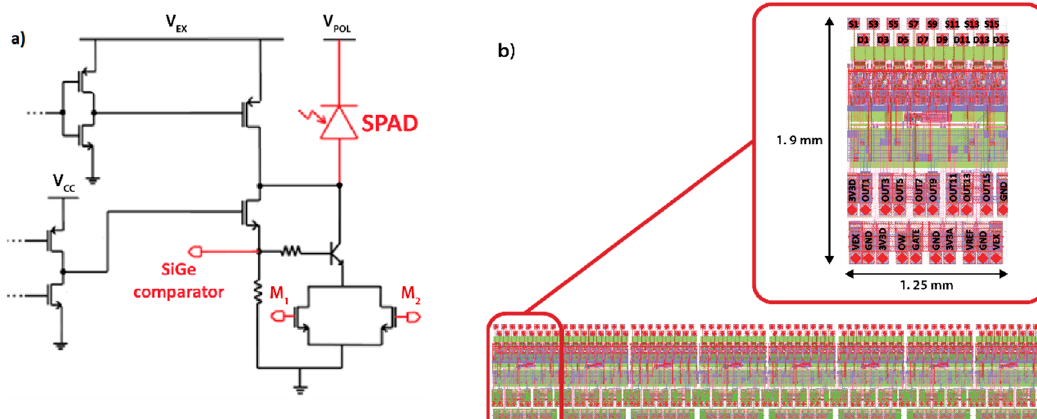
Figure 1. ( a ) Simplified schematic of the Single-Photon Avalanche Diode (SPAD) pulser circuit: the Bipolar Junction Transistor (BJT) transistor connected at SPAD anode node is active during the OFF-to-ON transient of the SPAD. The Metal-Oxide-Semiconductor (MOS) transistors M1 and M2, driven in ohmic regime, allow the variation of the current drawn by the BJT, thus the transient of the SPAD anode. An identic circuit (not shown) drives the dummy device and allows for differential sensing. ( b ) Layout of the complete 64 × 1 fast-gating Active Quenching Circuit (AQC) array and, in the inset, a single 8 × 1 block, composed of eight independent AQCs. On the top side are placed the contacts for the SPAD-dummy pairs, while on the bottom side two rows of bonding pads are placed for external connections.